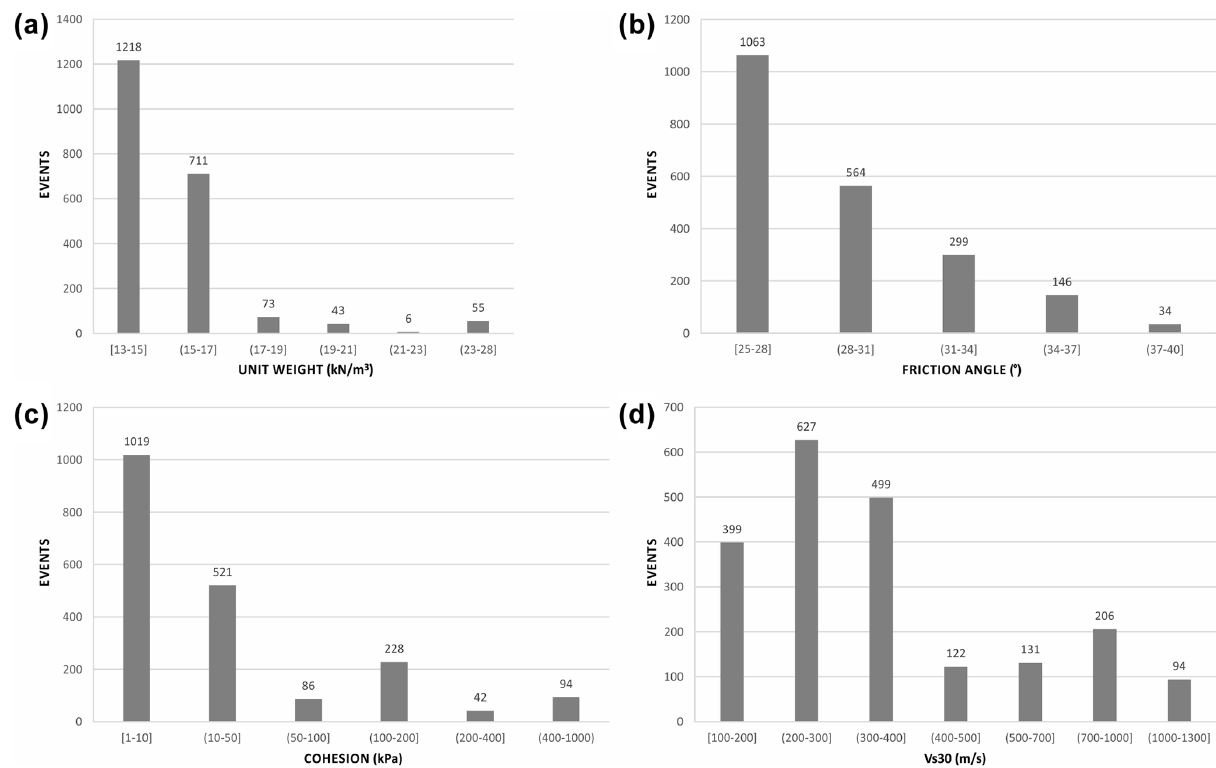
Figure 13. Distribution of the landslide events according to the unit weight (a) , friction angle (b) , cohesion (c) , and Vs30 (d) of the displaced